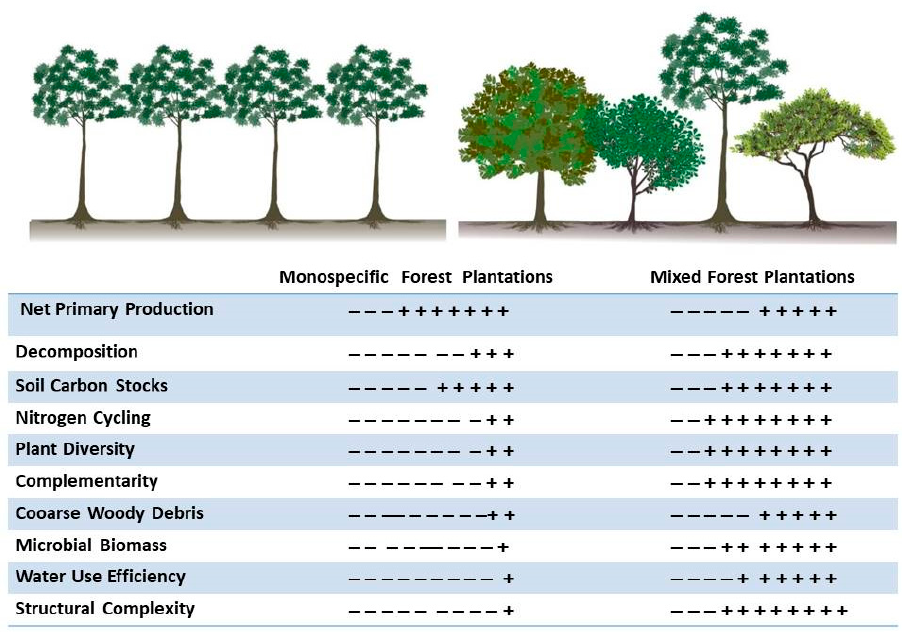
Figure 2. Differences in structure, function, and diversity in monospecific and mixed forest plantations.